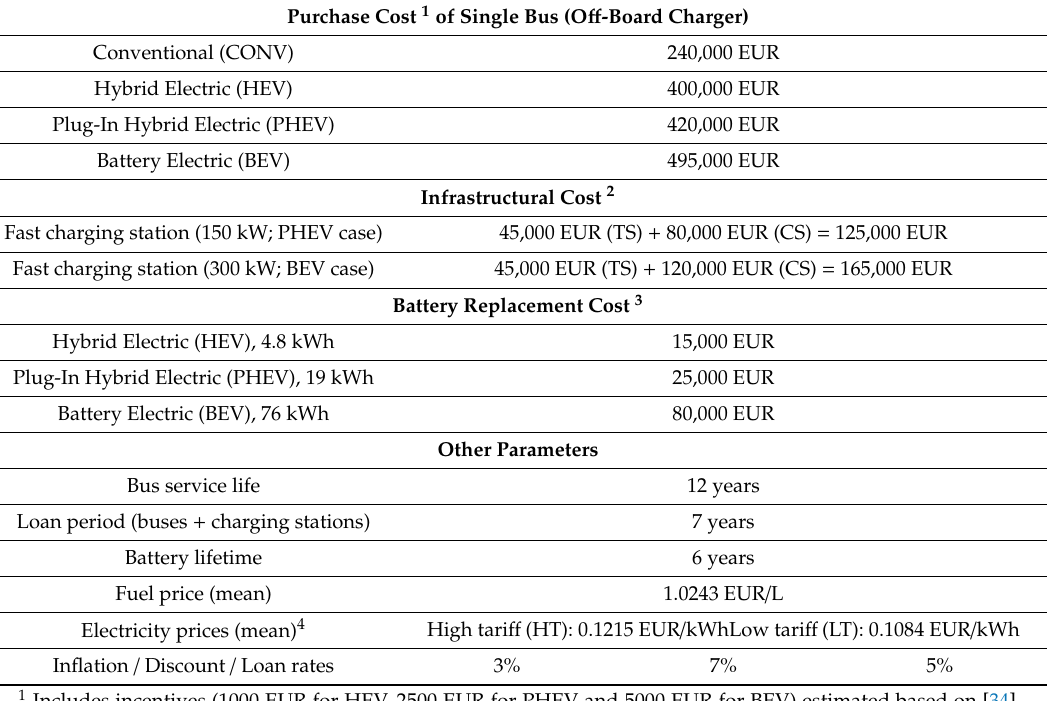
Figure 17. Flowchart of Techno-Economic Analysis Module (TEAM). Table 6. Input parameters used for TCO calculation for di ff erent bus types (no VAT is